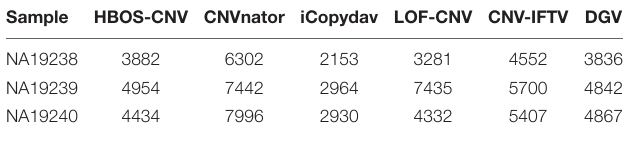
TABLE 1 | Comparison of CNV detection quantity between HBOS-CNV and other methods on real